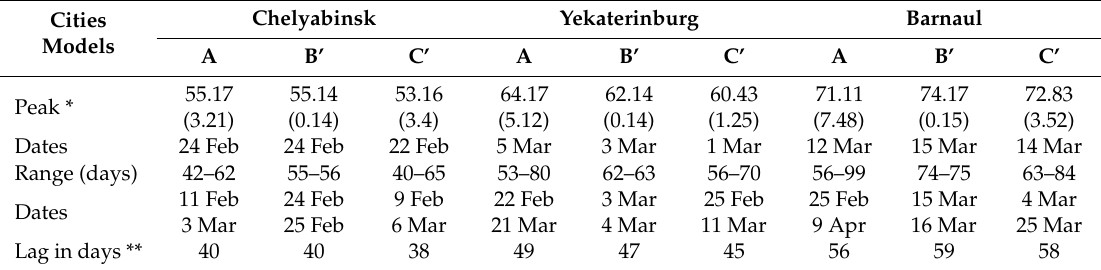
Table 5. The estimates of peak timing in rotaviral infection for a non-leap year for models A, B’, and C’.